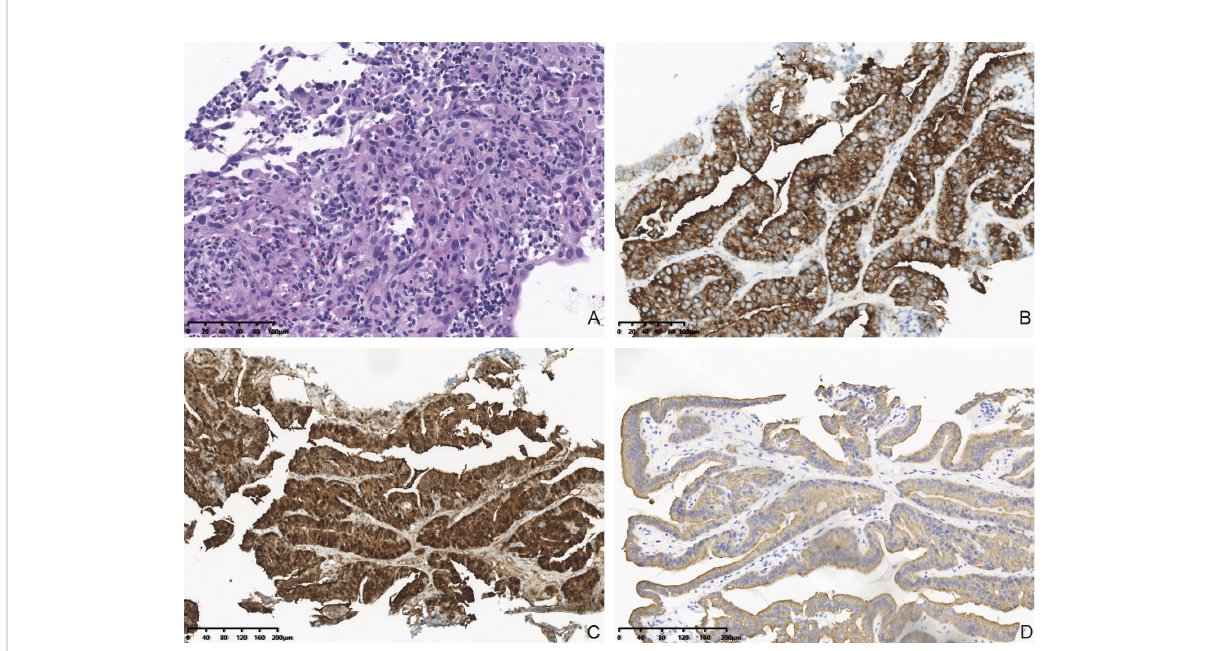
FIGURE 4 Hematoxylin and eosin (HE) stained FNAB of thyroid lobe (A) , 20× magni fi cation) revealed malignant epithelial cells. IHC staining showed that malignant cells in thyroid were positive for BRAR-VE (B) , 20× magni fi cation) and G-3 (C) , 20× magni fi cation) and CK19 (D) , 20× magni fi